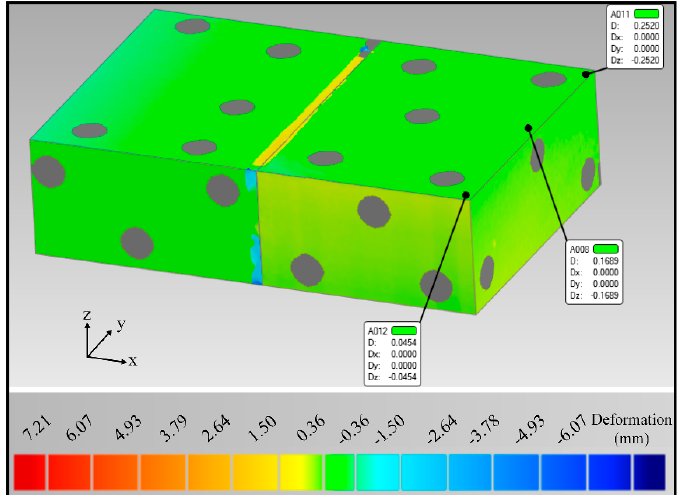
Figure 5. Deformation cloud after welding of the 40 mm-thick TC4 titanium alloy narrow gap laser welded joint.